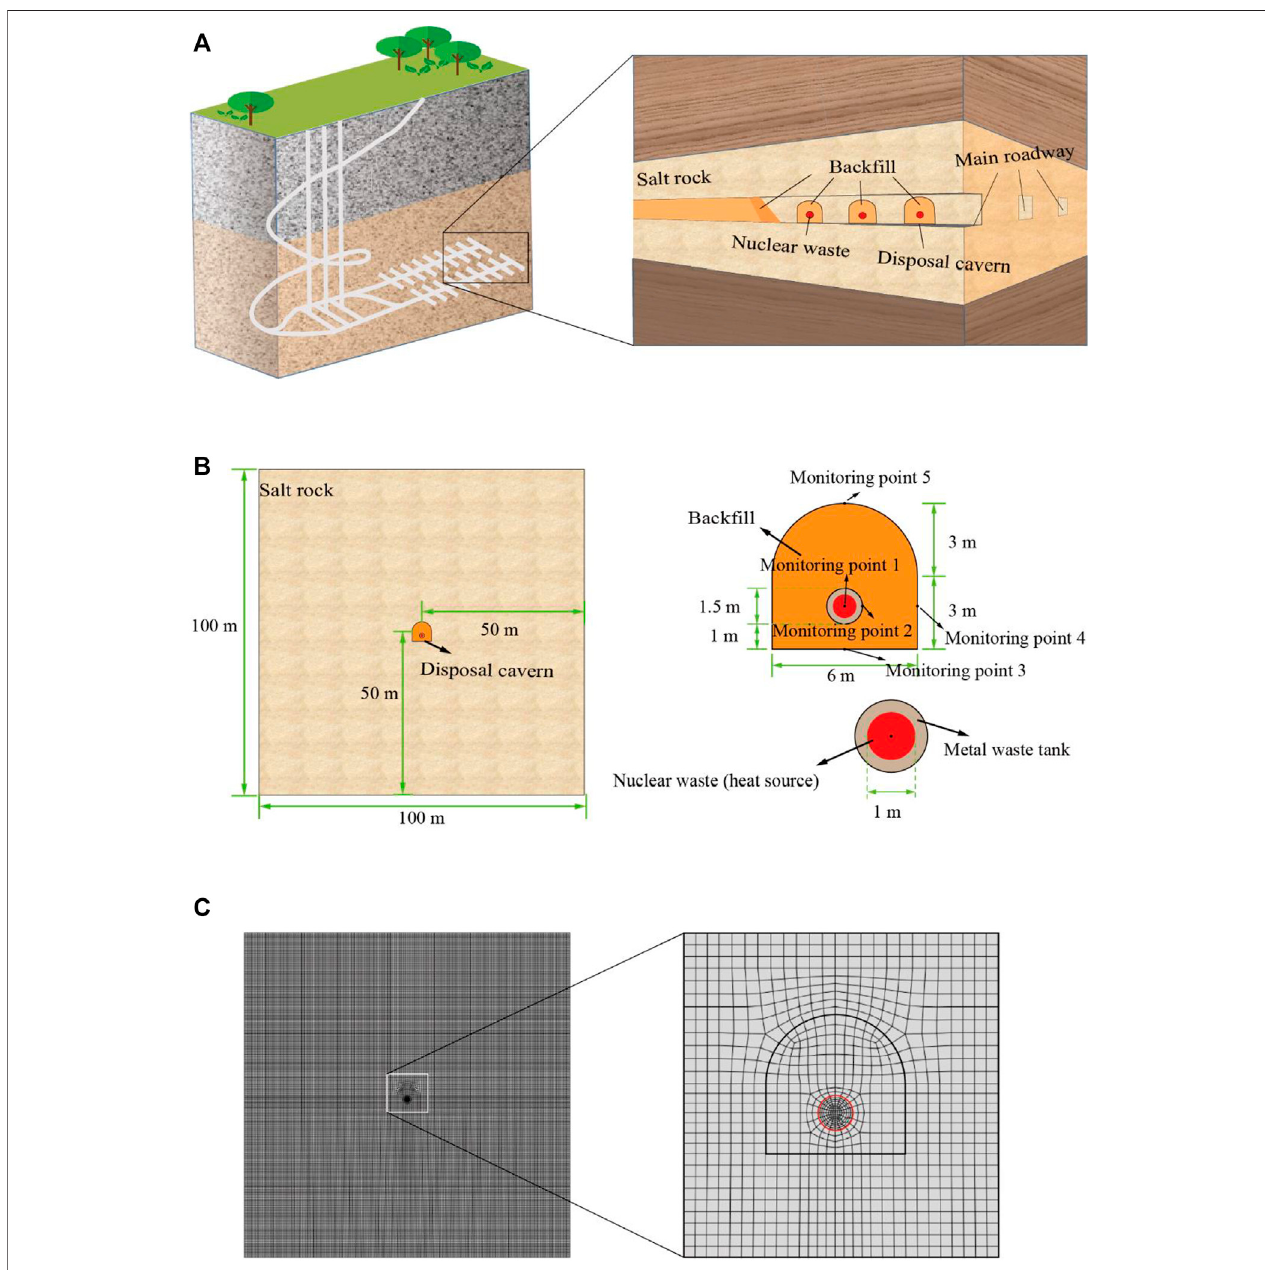
FIGURE 8 | Description of geological repository model for underground salt rock high-level radioactive nuclear waste. (A) Layout of nuclear waste repository; (B) Physical model geometry parameters and monitoring point location; (C) Model grid meshing.